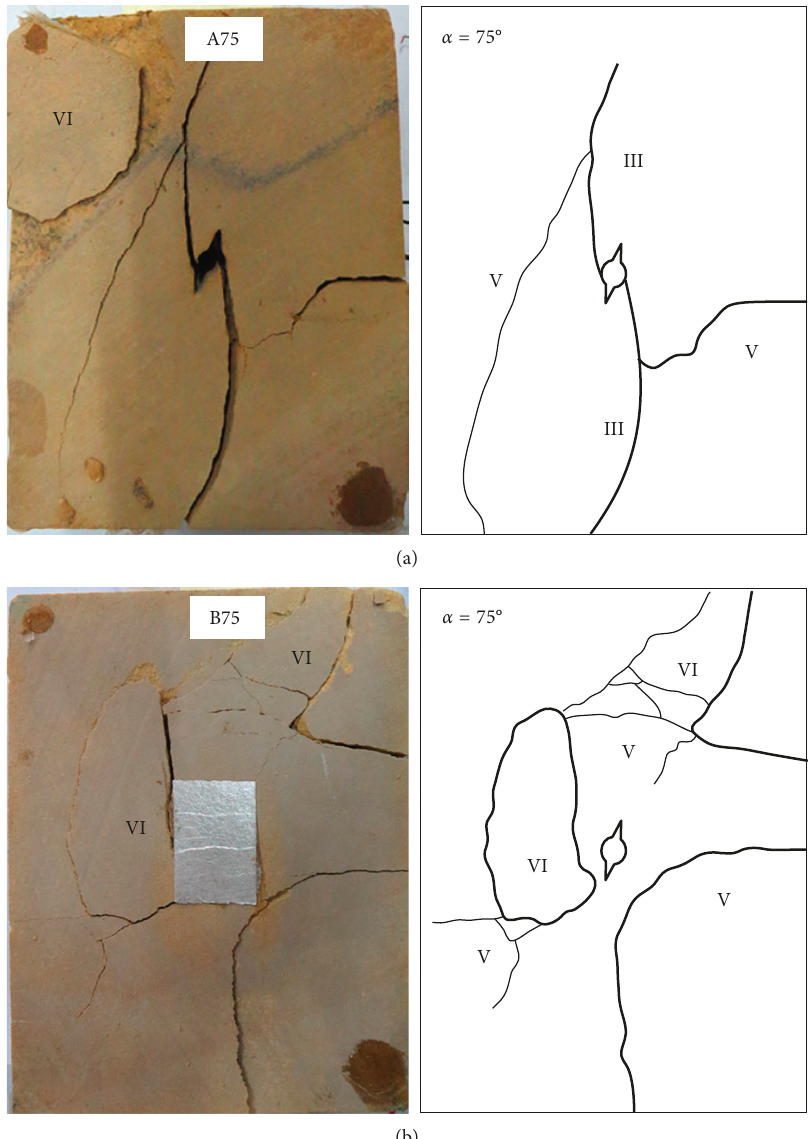
Figure 8: Effect of seepage pressure on ultimate failure modes of sandstone specimens containing fissure angle α pressure. (b) With seepage